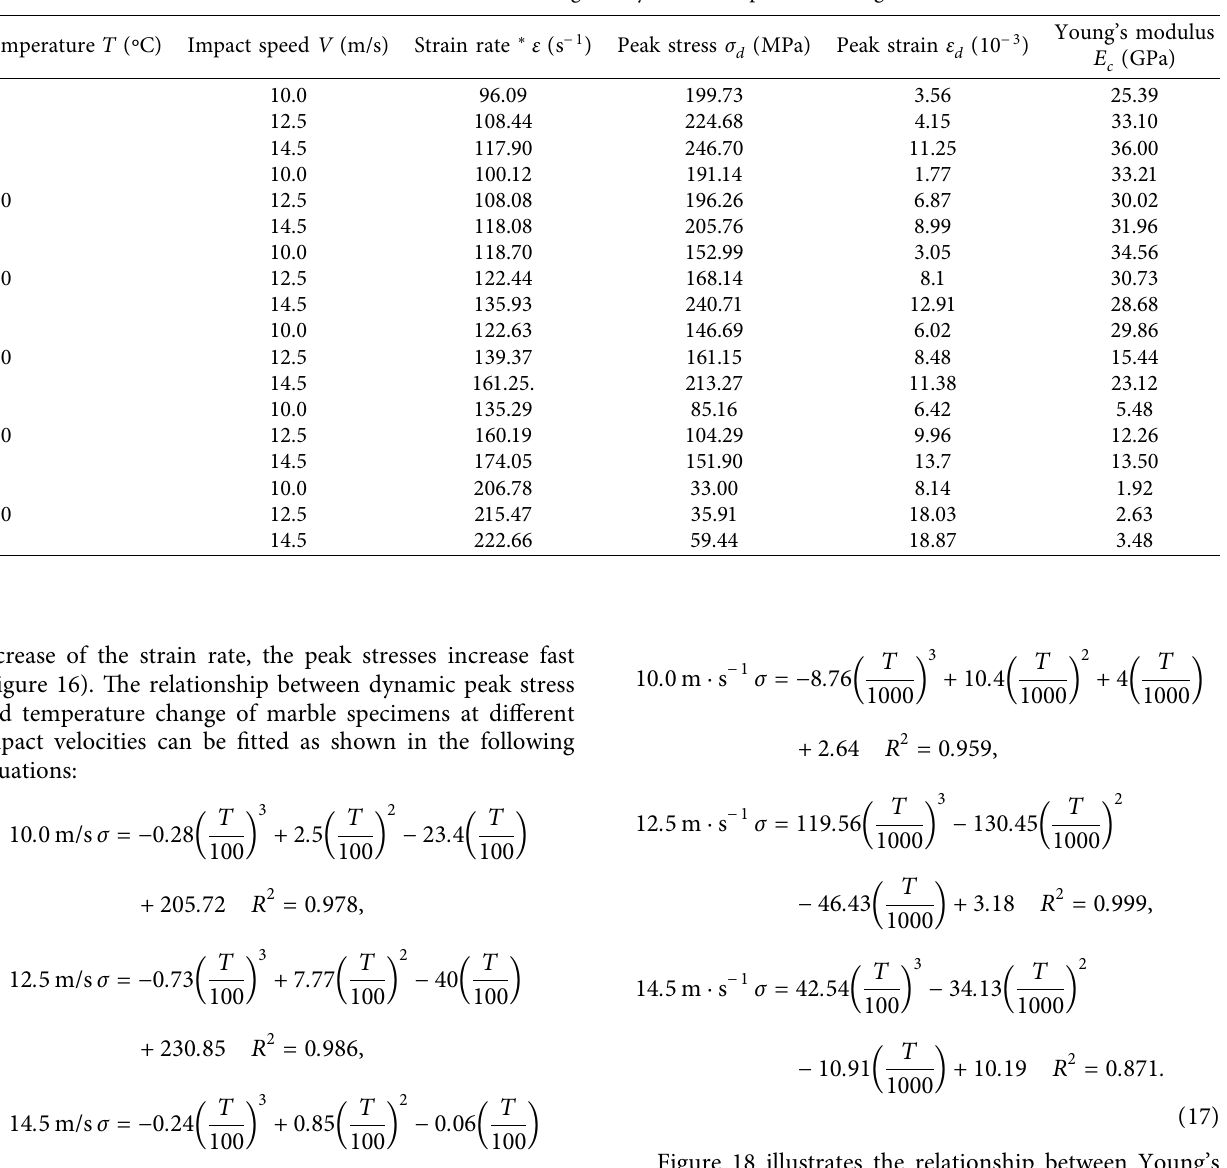
Table 3: Parameters obtained during the dynamic compressive strength